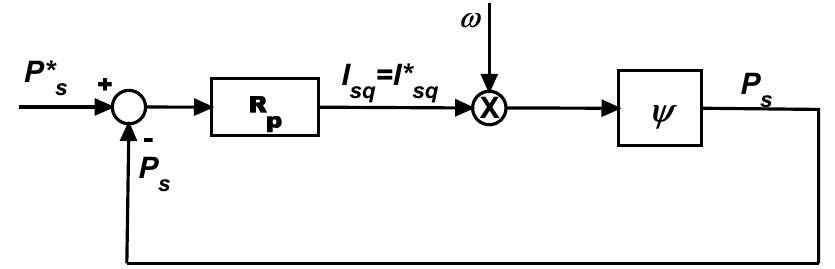
Figure 11. Simplified active power control loop for the synthesis of the regulator.